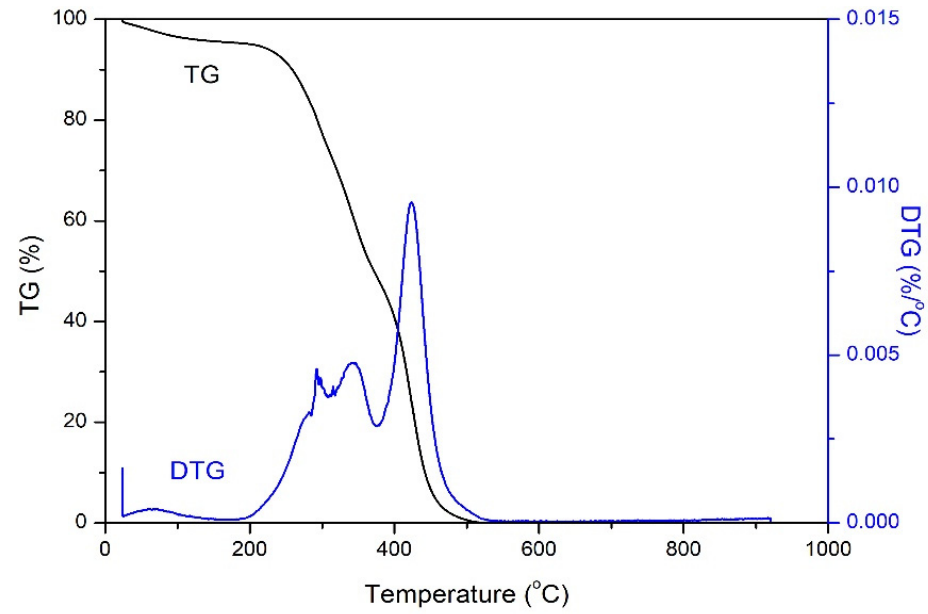
Figure 5. TGA analysis of polyurea B.